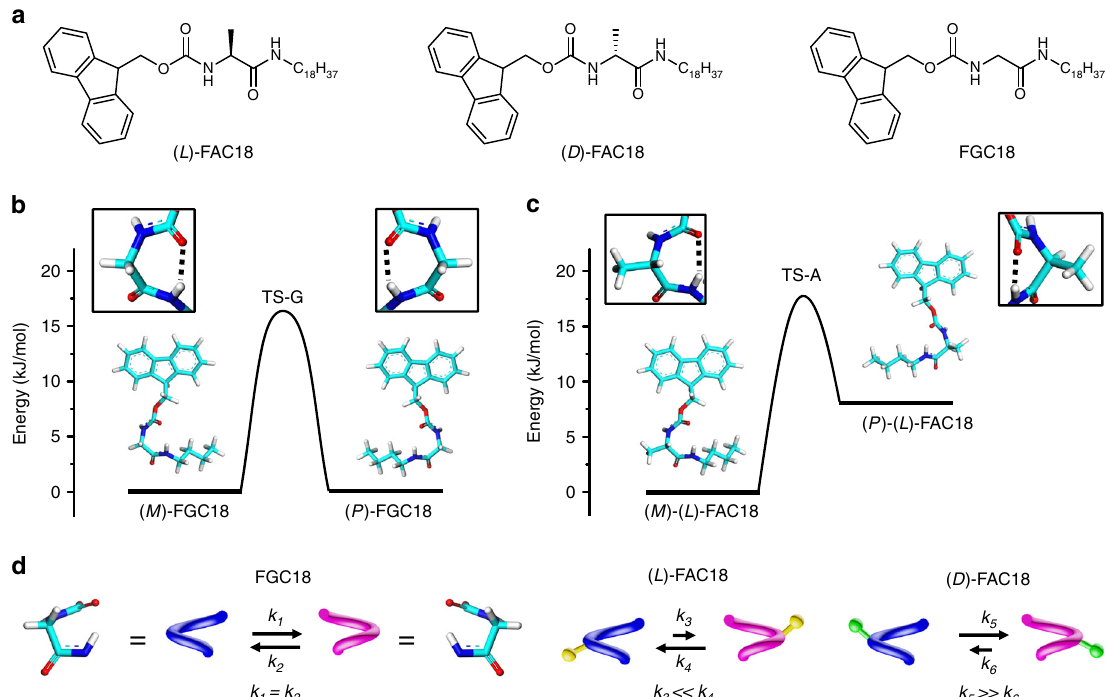
Fig. 2 Transient molecular conformations. a Molecular structures of ( L )-FAC18, ( D )-FAC18, and FGC18. b , c DFT-optimized geometries and corresponding energy diagrams of FGC18 and ( L )-FAC18, respectively. Insert boxes show the conformations of amino-acid segments. The black dashed lines indicate intramolecular hydrogen bonding. The transition-state structures are displayed in Supplementary Fig. 2. A C4 alkyl chain was used to reduce calculation time. d Schematic representation of the chemical equilibriums between M (in blue) and P (in magenta) twisting forms of FGC18, ( L )-FAC18, and ( D )-FAC18. The yellow and green pendent balls represent the methyl group at the chiral center of ( L )-FAC18 and ( D )-FAC18, respectively. k 1 , k 2 , k 3 , k 4 , k 5 , and k 6 are the rate constants of helical reversal